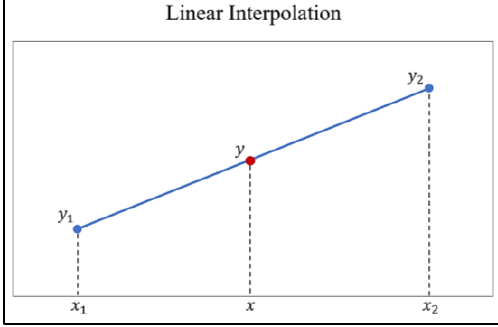
Figure 7. Linear interpolation illustration.